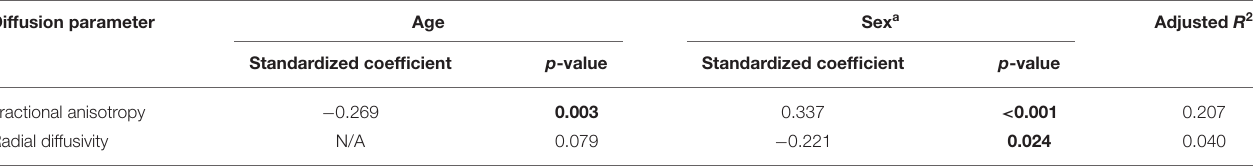
TABLE 1 | Multiple linear regression model for fractional anisotropy and radial diffusivity of the optic